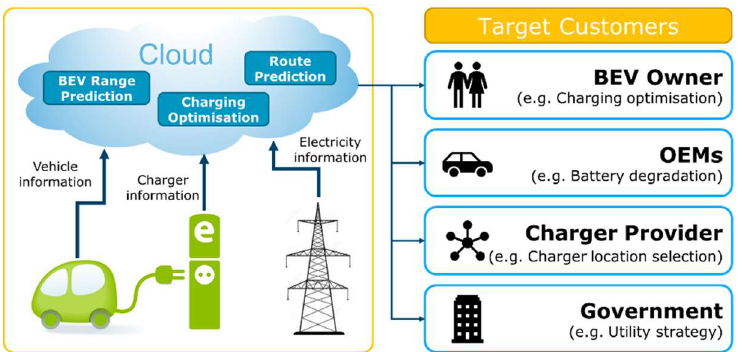
Figure 1. Cloud-based big data platform for Vehicle-to-Grid (V2G). BEV, Battery Electric Vehicle; OEMs, Original Equipment Manufacturers.